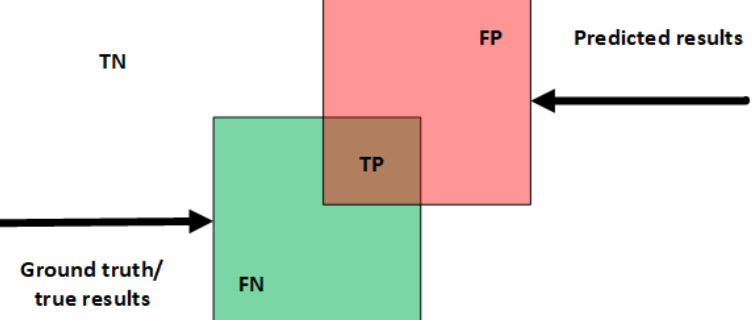
Figure 9. Relationship between TP, TN, FN, and FP.